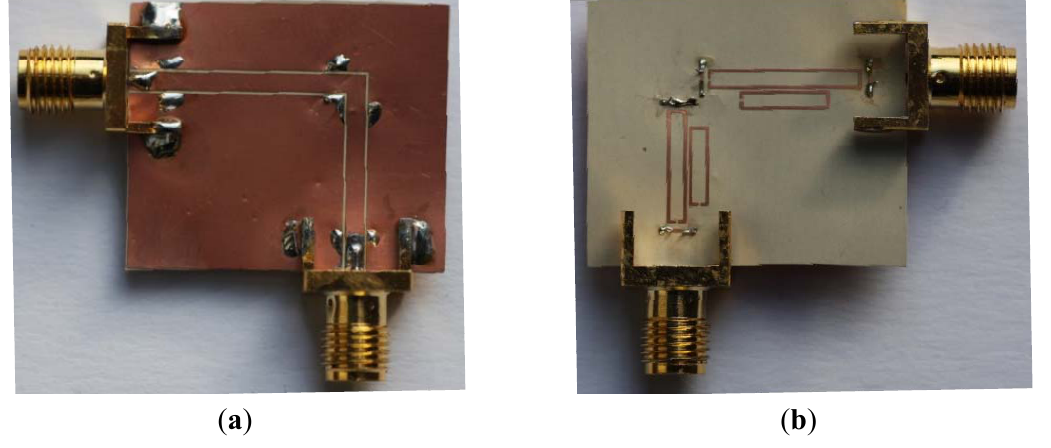
Figure 5. Photograph of the proposed device for the aligned position; ( a ) top and ( b ) bottom